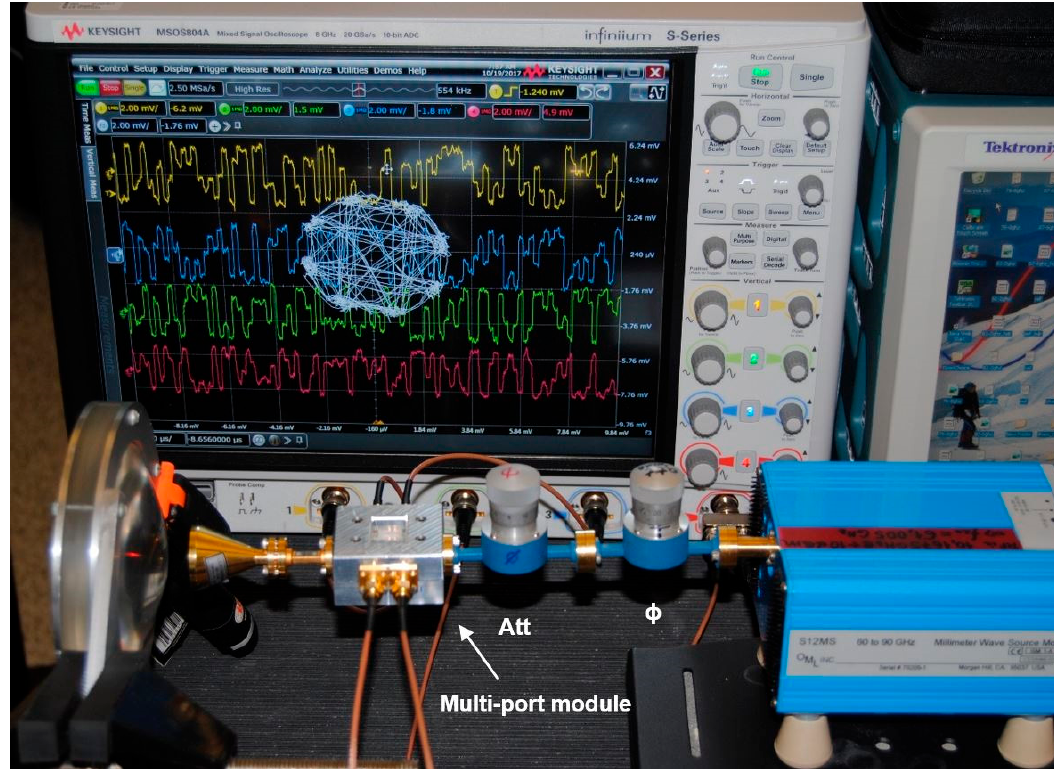
Figure 41. V-band multi-port characterization using modulated signals: detail of the down-conversion.